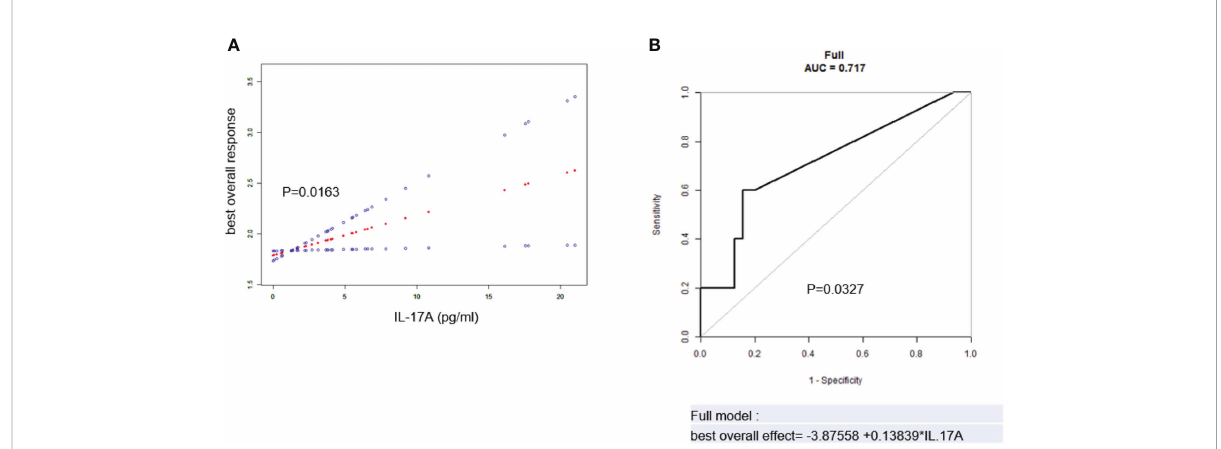
FIGURE 3 (A) Spline smoothing curve for the cross-sectional correlation between serum IL-17A and best overall effect (BOE) (p = 0.0163). (B) Predictive model and ROC analysis for IL-17A and BOE (p = 0.0327). The model was adjusted for age, sex, hypertension history, diabetes history,